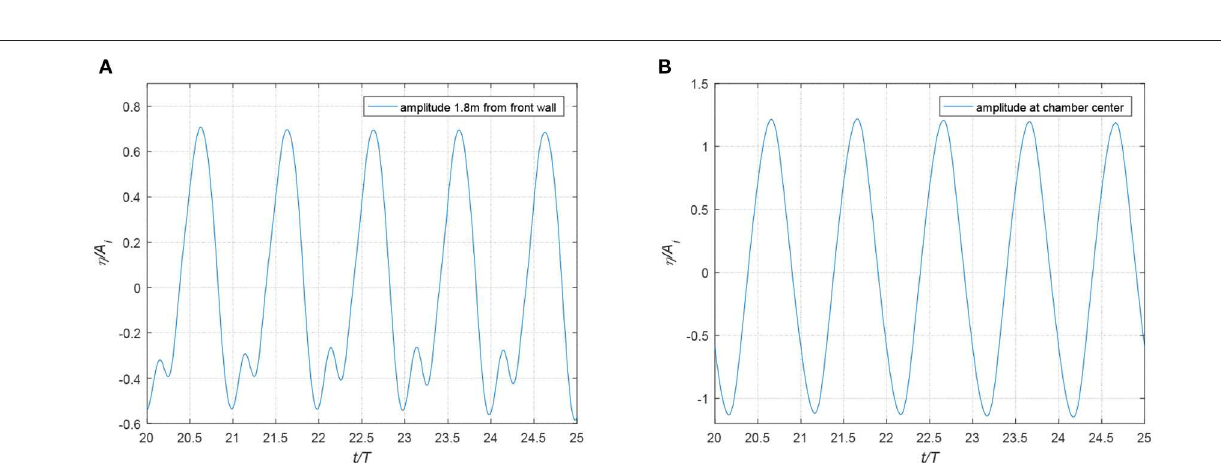
FIGURE 13 | Non-dimensionalized free surface elevation (A) at a position 1.8m from the front wall of OWC chamber (B) at the chamber center.